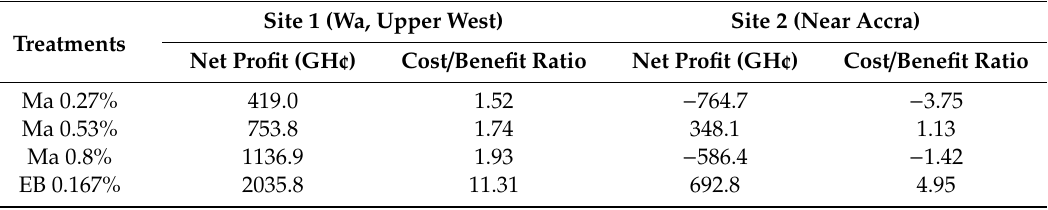
Table 1. Net profits and cost–benefit values for the e ff ect of maltodextrin-based treatments (Ma) aiming Figure 3. Mean maize cob damage induced by FAW + SD ( A ) and mean maize yields ( B ) after to control fall armyworm in maize in Ghana compared to the negative control. Emamectin benzoate treatment with various concentrations of maltodextrin for site 1 near Wa, Upper West, Ghana, and (EB) was applied as a positive site 2 near Accra, Ghana. Bars for yield at site 1 sharing the same letters are not significantly different from each other for the yield data, while missing letters indicate that no significant differences were found.